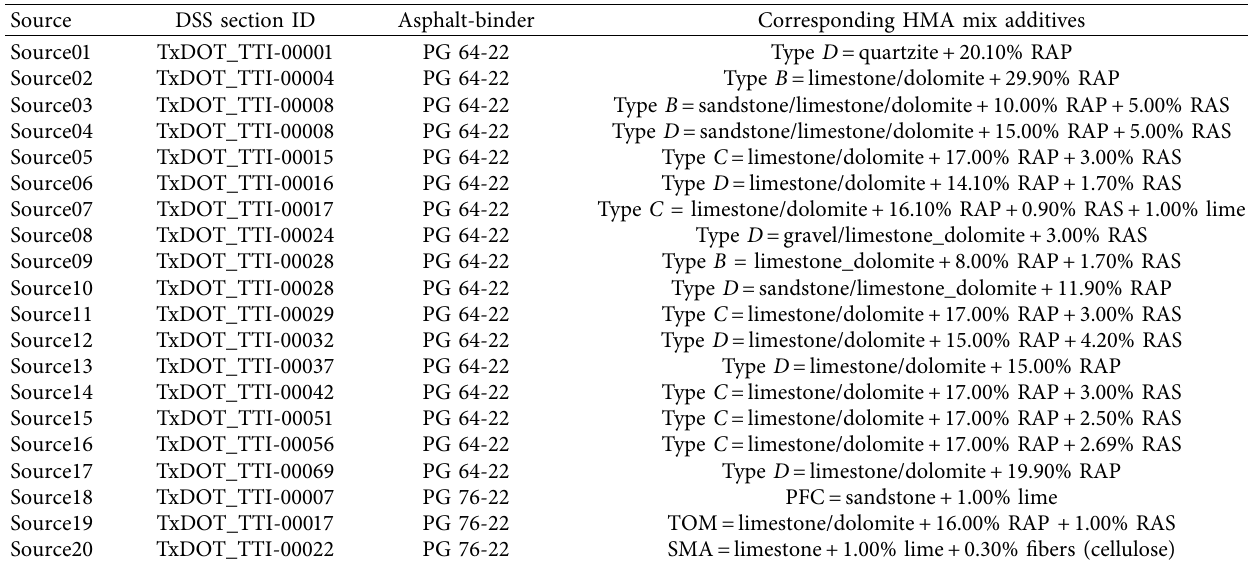
Figure 1: Ductility (ER) test: (a) specimens testing; (b) specimens after elongation; (c) specimens after being cut mid-way and resting to allow recovery. Table 1: Plant-mix extracted